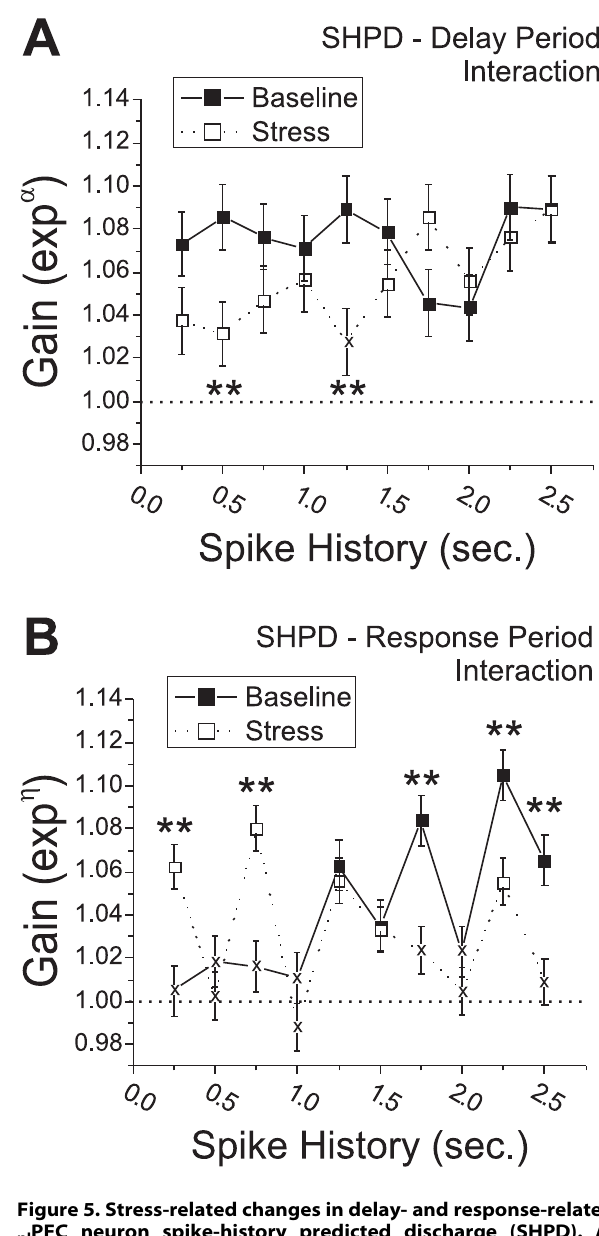
Figure 5. Stress-related changes in delay- and response-related pl PFC neuron spike-history predicted discharge (SHPD). A ) Delay-specific gains of SHPD interaction terms from the CI-GLM (Model 2; a , g ) were averaged across pl PFC neurons and plotted. B ) Response interval-specific gains of SHPD interaction terms (Model 3). Stress suppressed delay-specific SHPD gains and increased the impact of the most recent spiking history during the response period. (*p , 0.05 FDR corrected compared to baseline; x , 0.05 FDR corrected compared to